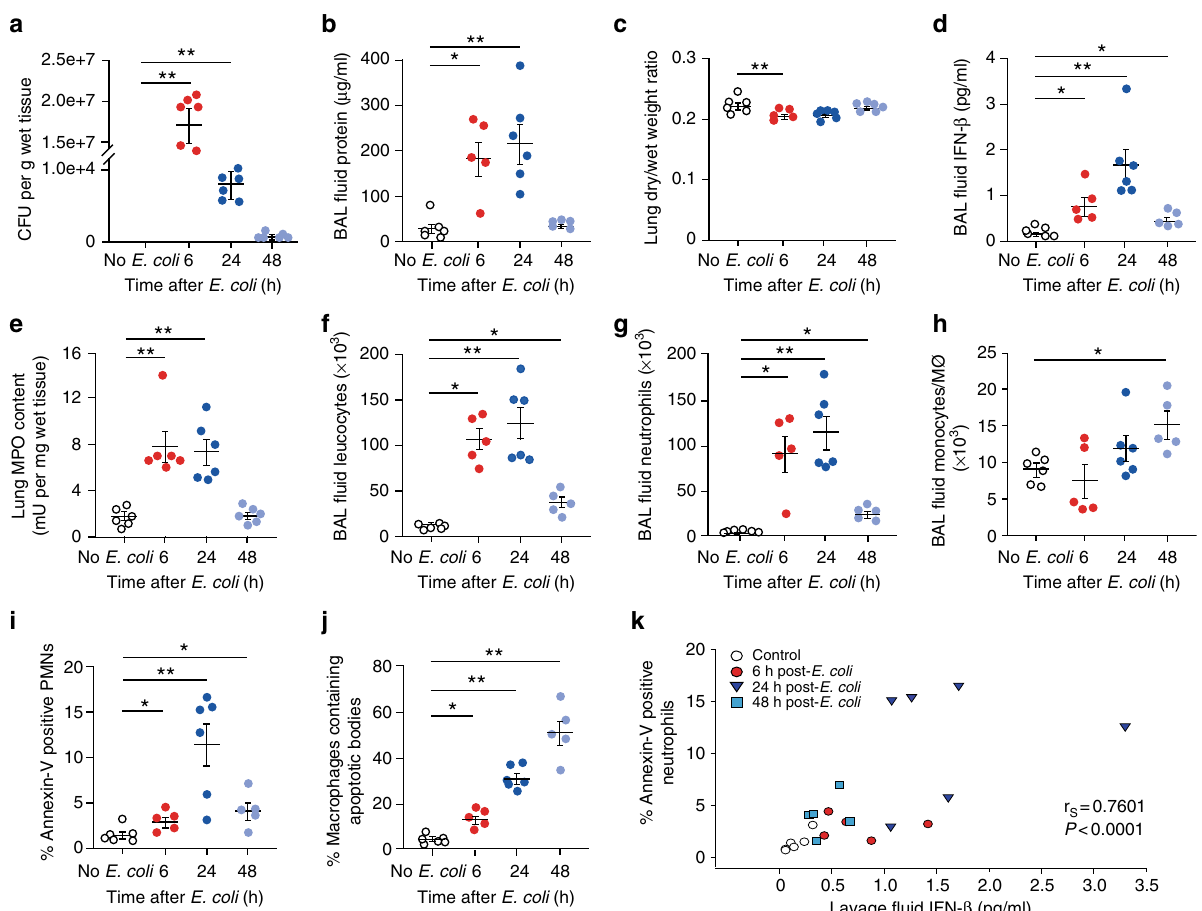
Fig. 2 Enhanced IFN- β production during the resolution of E.coli pneumonia. Under iso fl urane anesthesia, female C57BL/6 mice were injected intratracheally with 5*10 6 live E. coli . At the indicated times, lungs were collected without lavage and analyzed for E. coli content ( a ), lung dry-to-wet weight ratio ( c ) and tissue MPO activity ( e ). In separate groups of mice bronchoalveolar lavage fl uid protein concentration ( b ), IFN- β levels ( d ), total leukocyte ( f ), neutrophil ( g ) and monocyte/macrophage numbers ( h ) and the percentage of annexin-V-positive (apoptotic) PMN ( i ) and the percentage of BAL fl uid macrophages containing apoptotic bodies ( j ) were determined. Results are means ± SEM ( n = 6 mice per group). * P < 0.05, ** P < 0.01 (Dunn ’ s multiple contrast hypothesis test). k Neutrophil apoptosis positively correlates with lavage fl uid IFN- β levels (Spearman correlation analysis). Source data are provided as a Source Data fi CpG DNA reduced surface expression of IFN α R1 that binds IFN- β within 2 h of culture (Supplementary Fig. 6a – b), whereas IFN- β did not affect the uptake of labeled oligodeoxynucleotides by PMN (Supplementary Fig. 6c). These fi ndings indicate the ability of IFN- β to redirect neutrophils to apoptosis even when its receptor is slightly downregulated in the presence of CpG DNA, and suggest that diminishing IFN α R1 expression is part of the survival cascade induced by CpG DNA. The IFN- β pro-apoptotic signal appears to be predominantly mediated through STAT3 activation and not by reducing CpG DNA uptake by